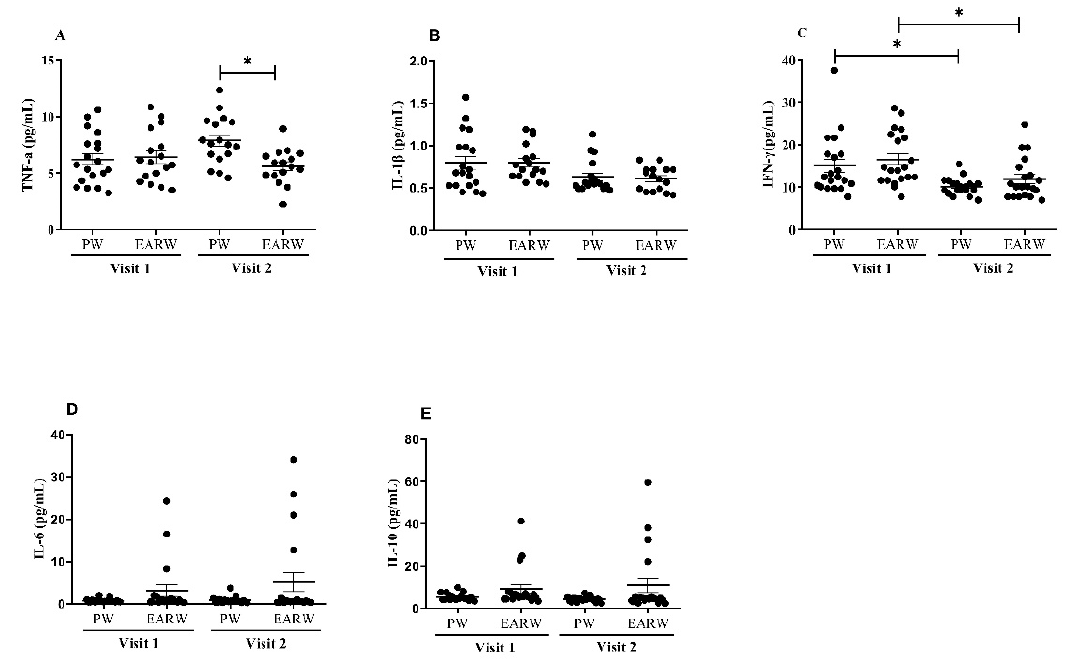
Figure 5. Effects of drinking EARW on the levels of serum inflammatory cytokines in FD patients. Blood was collected from the participants at baseline (visit 1) and after 6 weeks of intervention (visit 2). The charts show serum TNF- α ( A ), serum IL-1 β ( B ), serum IFN- γ ( C ), serum IL-6 ( D ), and IL-10 ( E ) levels. Data are presented as mean, MD, and p -value between two groups. Significant differences were analyzed using one-way ANOVA by Tukey’s multiple comparisons test. * p < 0.05. PW: purified water group; EARW: electrolyzed alkaline-reduced water group.